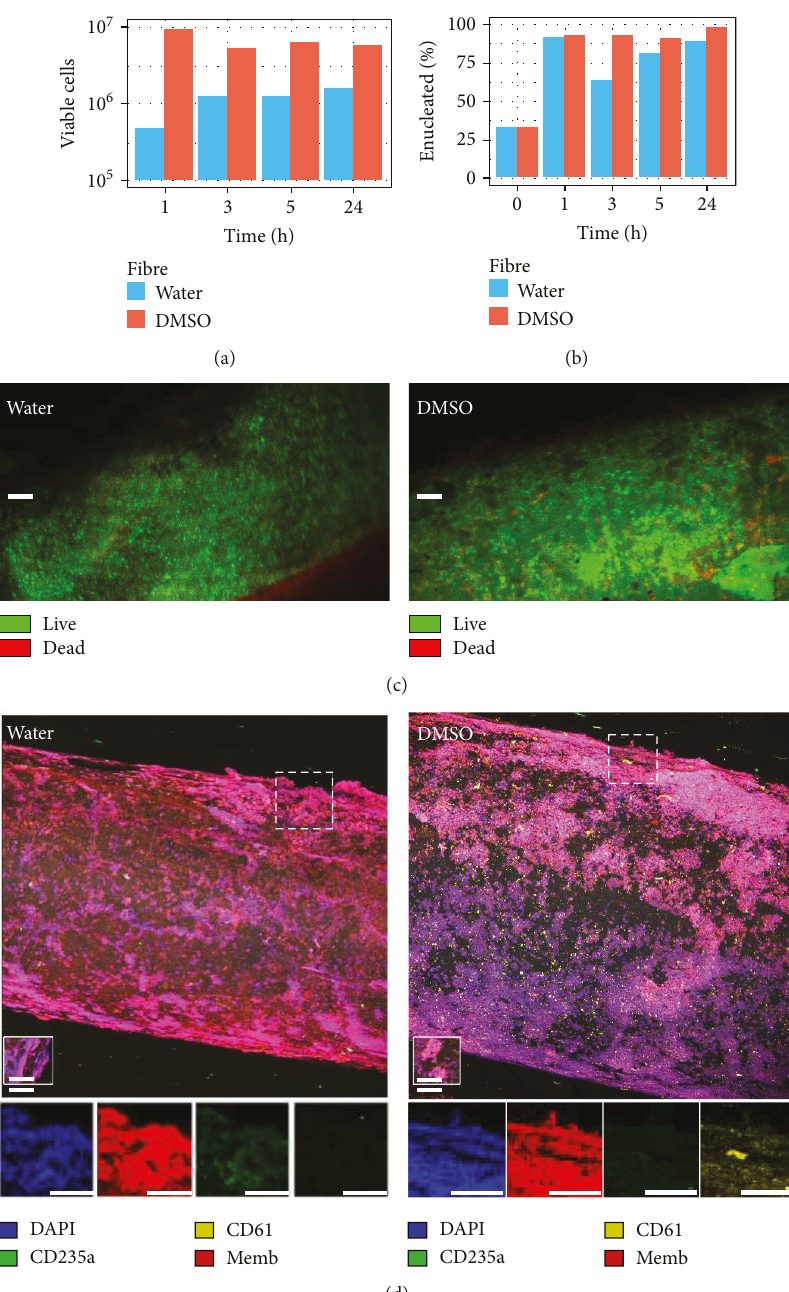
Figure 4: Cross- fl ow fi ltration e ffi ciency. (a) Number of viable and (b) percent enucleate cells collected at fi bre outlets counted by trypan blue and methylene blue dye exclusion at di ff erent time points of fi ltration. (c) Comparison of cell viability within the water (left) and DMSO (right) fi bres after 24 hours of perfusion using confocal microscopy by detection of calcein AM (green), ethidium homodimer-1 (red), and laser re fl ectance (grey) (100 μ m scale). (d) Comparison of cells types remaining within fi bres by detection of (top) nuclei (DAPI; blue), red blood cell marker CD235a (green), platelet marker CD61 (yellow), plasma membranes (CellMask; red), and laser re fl ectance (grey) and (below) single stains of hatched box regions (100 μ m